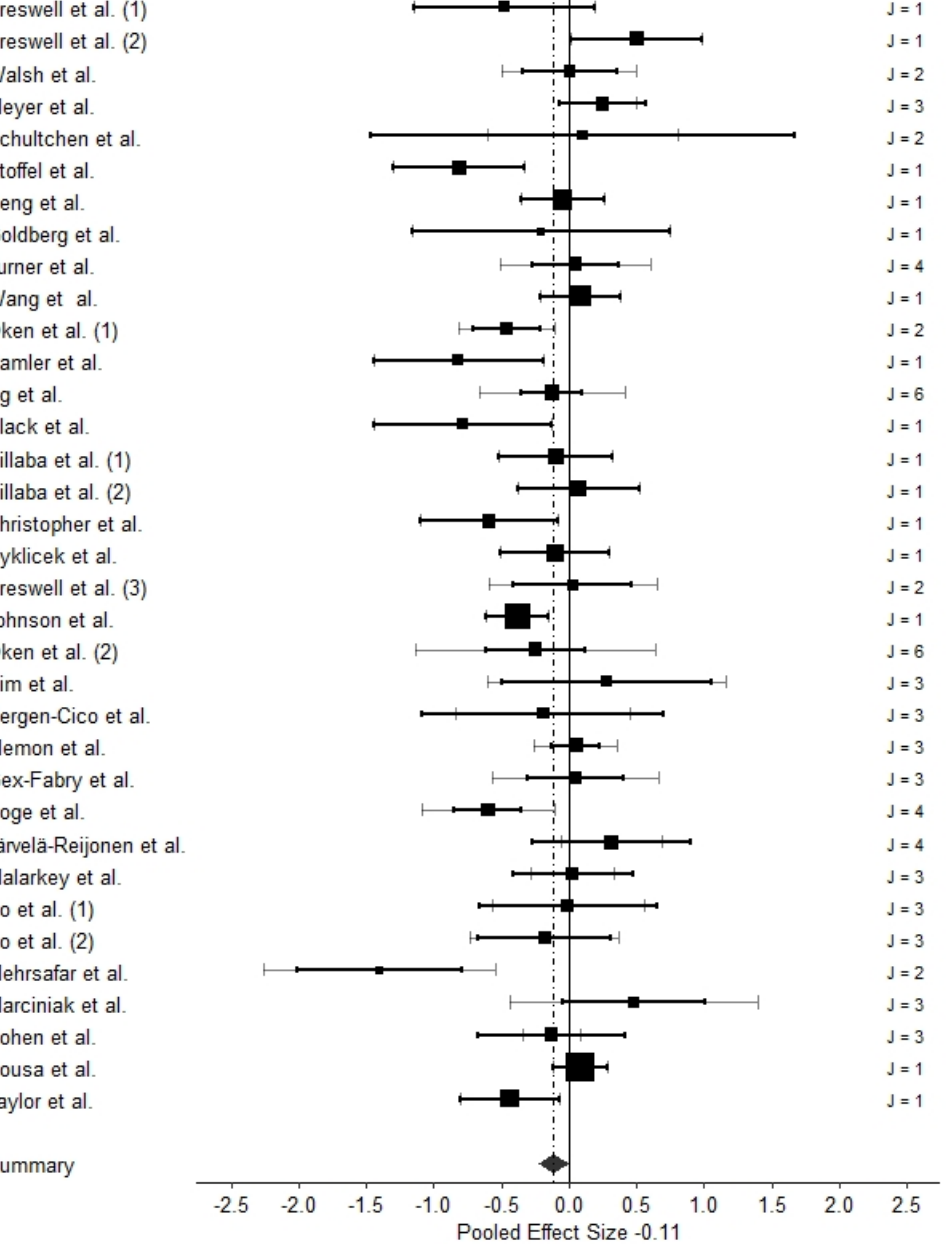
Figure 5. Three-Level Forest Plot of TLMA 2. Note. References of included studies are provided in Table 2. Numbers in parentheses refer to different samples of the respective studies (see Table 2 for details). Aggregated effect sizes on the study level (Level 3) are represented as squares, whose size indicates the weight for the meta-analytic pooled effect estimate; black lines represent 95% confidence intervals of the aggregated effect sizes within each study (Level 3); grey lines represent 95% confidence intervals of the median precision of each individual effect size (Level 2) within each study. The black diamond represents the pooled effect estimate with its 95% confidence interval. J is the number of biomarkers within each study.